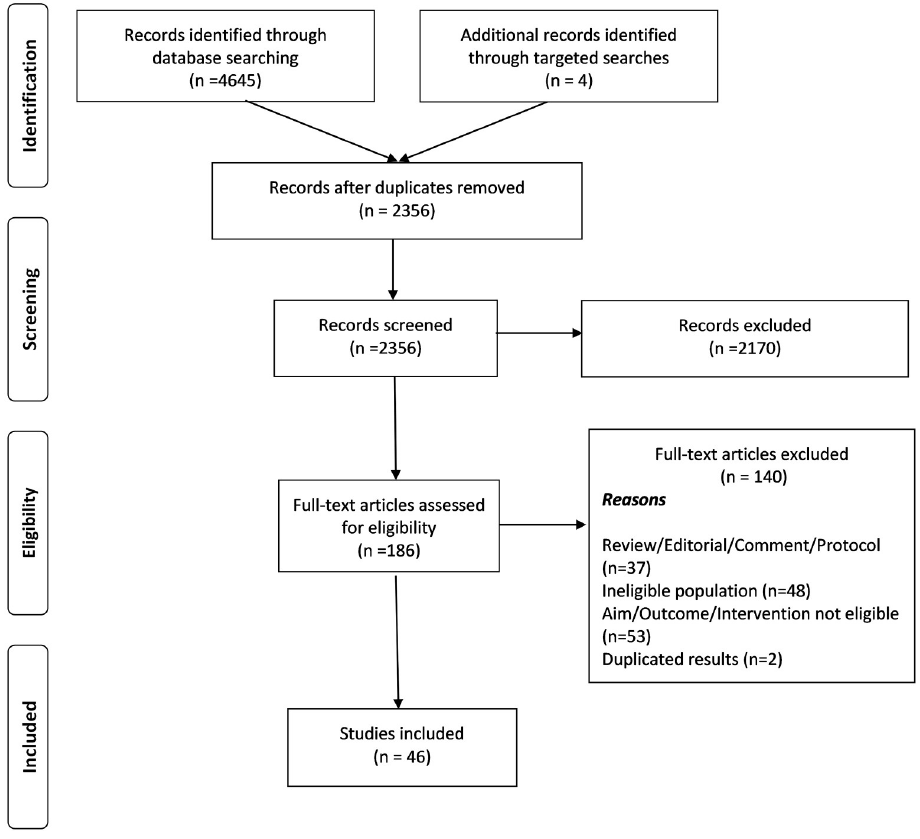
Fig 1. Flow diagram of search strategy